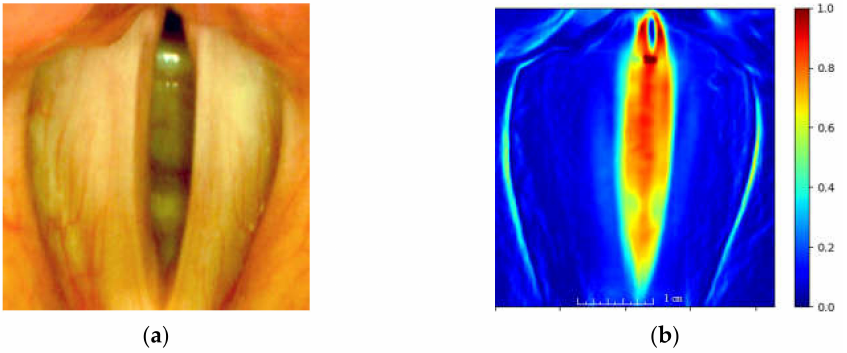
Figure 7. The image of the glottis of a normophonic subject ( a ) and the corresponding total variation image ( b ), as defined in Equation (1), represented as a heat map (the larger the variation, the warmer the color of the